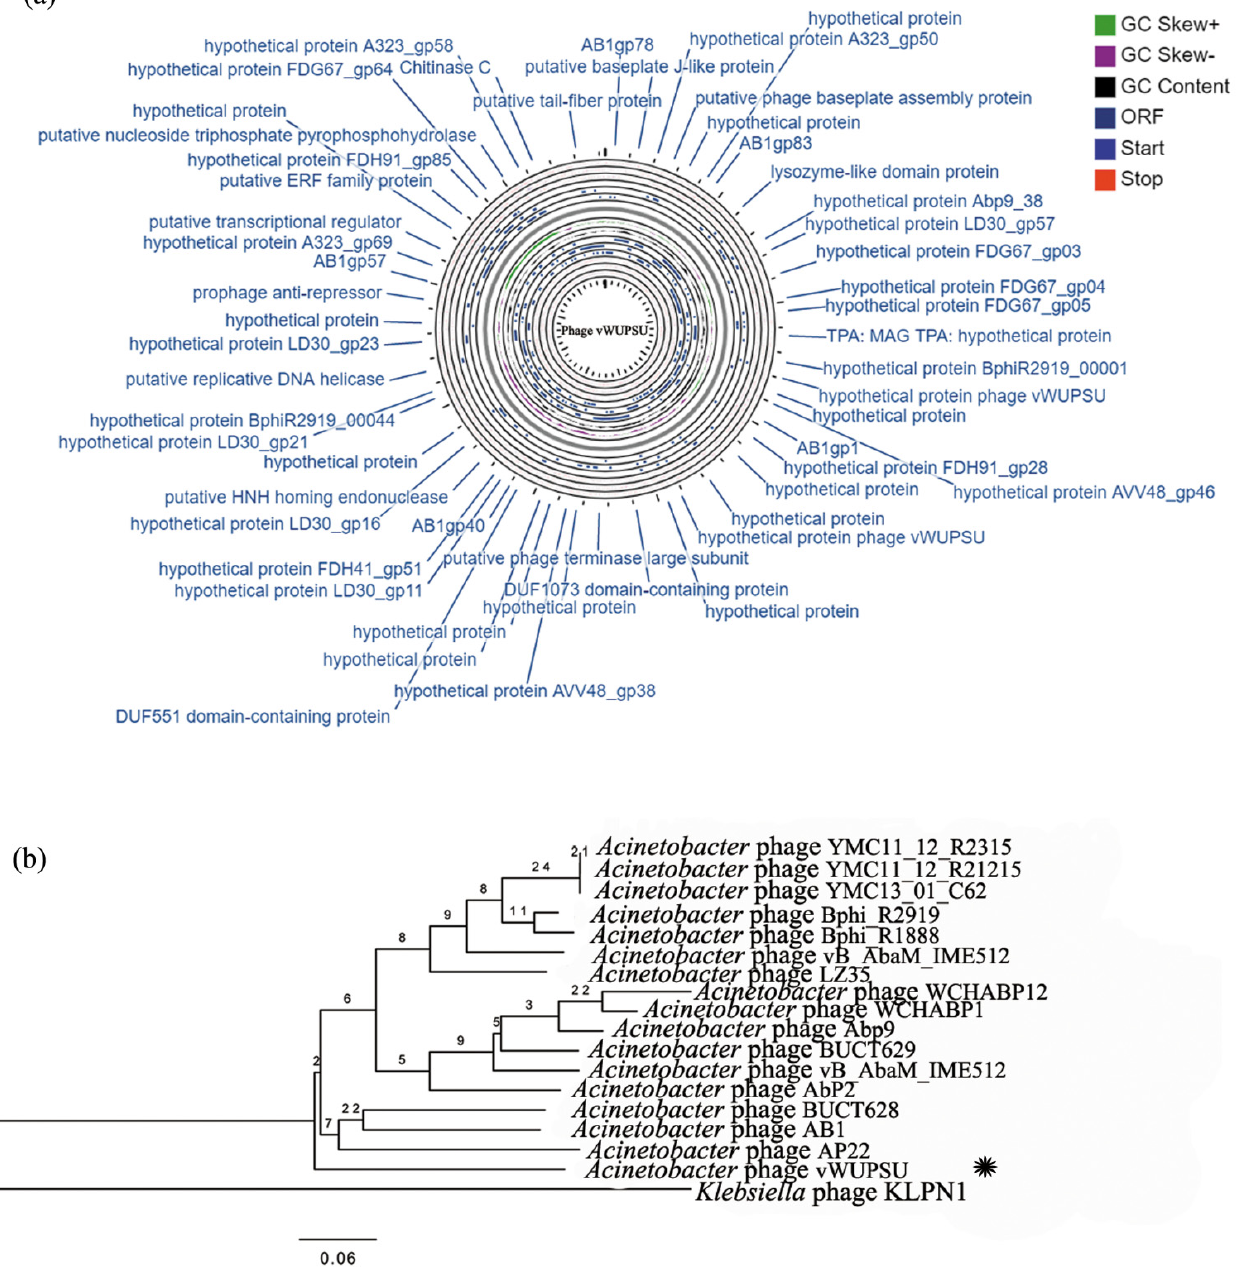
Figure 2. Phage vWUPSU genomic analysis. ( a ) Map of phage vWUPSU genome. The genome map was generated by GC viewer server [28]; ( b ) phylogenetic tree of phage vWUPSU constructed based